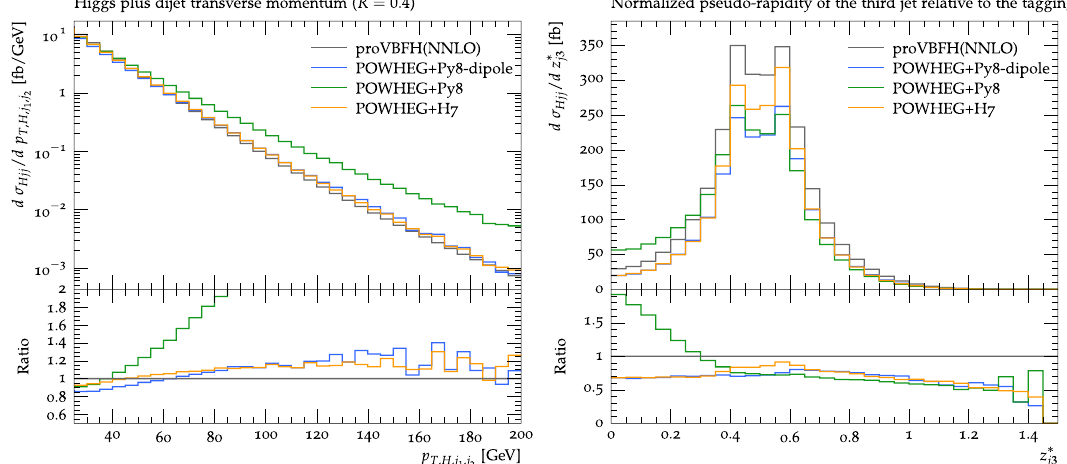
Fig. 8 Transverse-momentum of the Higgs-plus-tagging-jets system (left)andZeppenfeldvariableofthethirdjet(right)asdefinedinEq.(7), within the cuts of Eqs. (3)–(4) at NNLO, and at NLO + PS accuracy